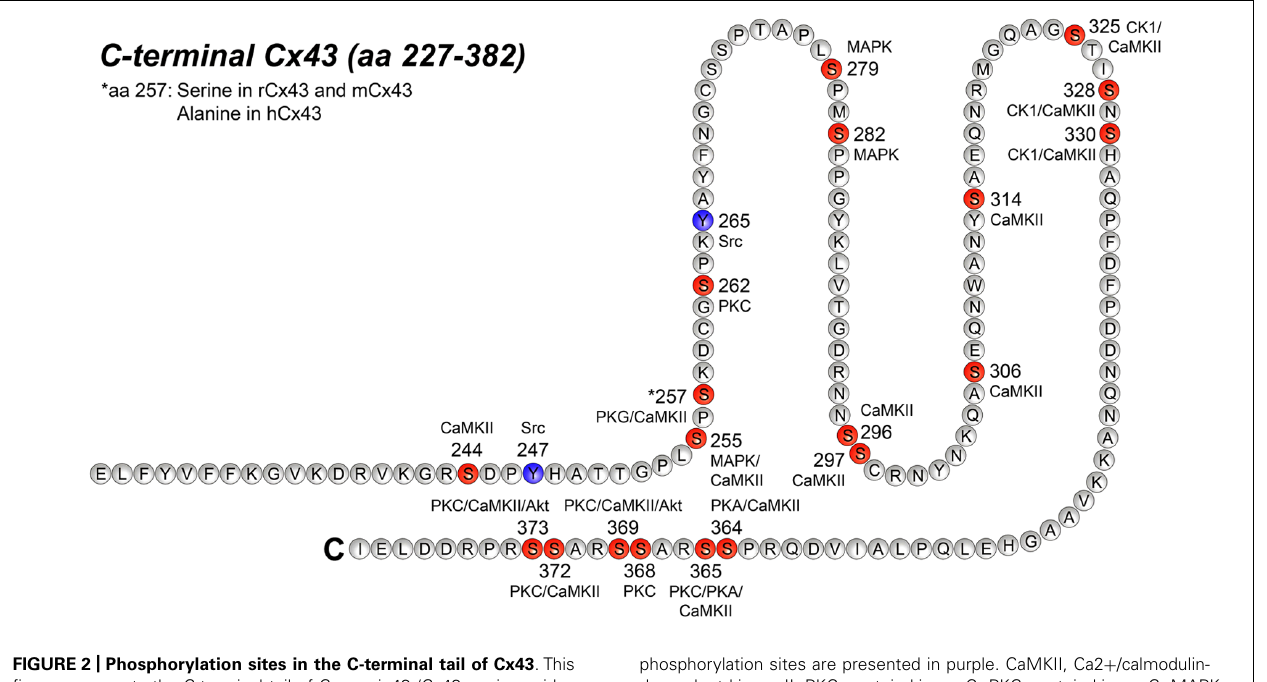
FIGURE 2 | Phosphorylation sites in the C-terminal tail of Cx43 . This figure represents the C-terminal tail of Connexin43 (Cx43; amino acid, aa 227–382) including its phosphorylation sites and its respective kinases. Serine (S) phosphorylation sites are presented in red and tyrosine (Y)